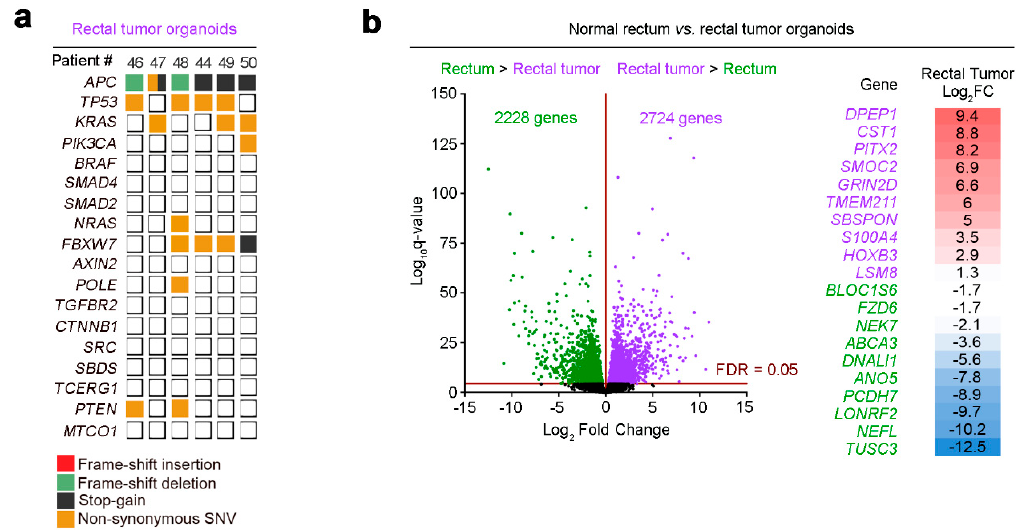
Figure 2. Mutational analysis and transcriptome profiles of human rectal tumor organoids. ( a ) Overview of the mutations found in the rectal tumor organoid cultures of six patients. ( b ) Volcano plot comparing normal rectum and rectal tumor RNA-seq signatures from six organoid cultures. The x -axis shows Log 2 FC and the y -axis shows the q -value ( − Log 10 ). Green / purple dots represent downregulated / upregulated (respectively) genes in rectal tumor organoids. The table lists the top 10 (lowest q -value) upregulated / downregulated genes in rectal tumor organoids ordered by their Log 2 FC.